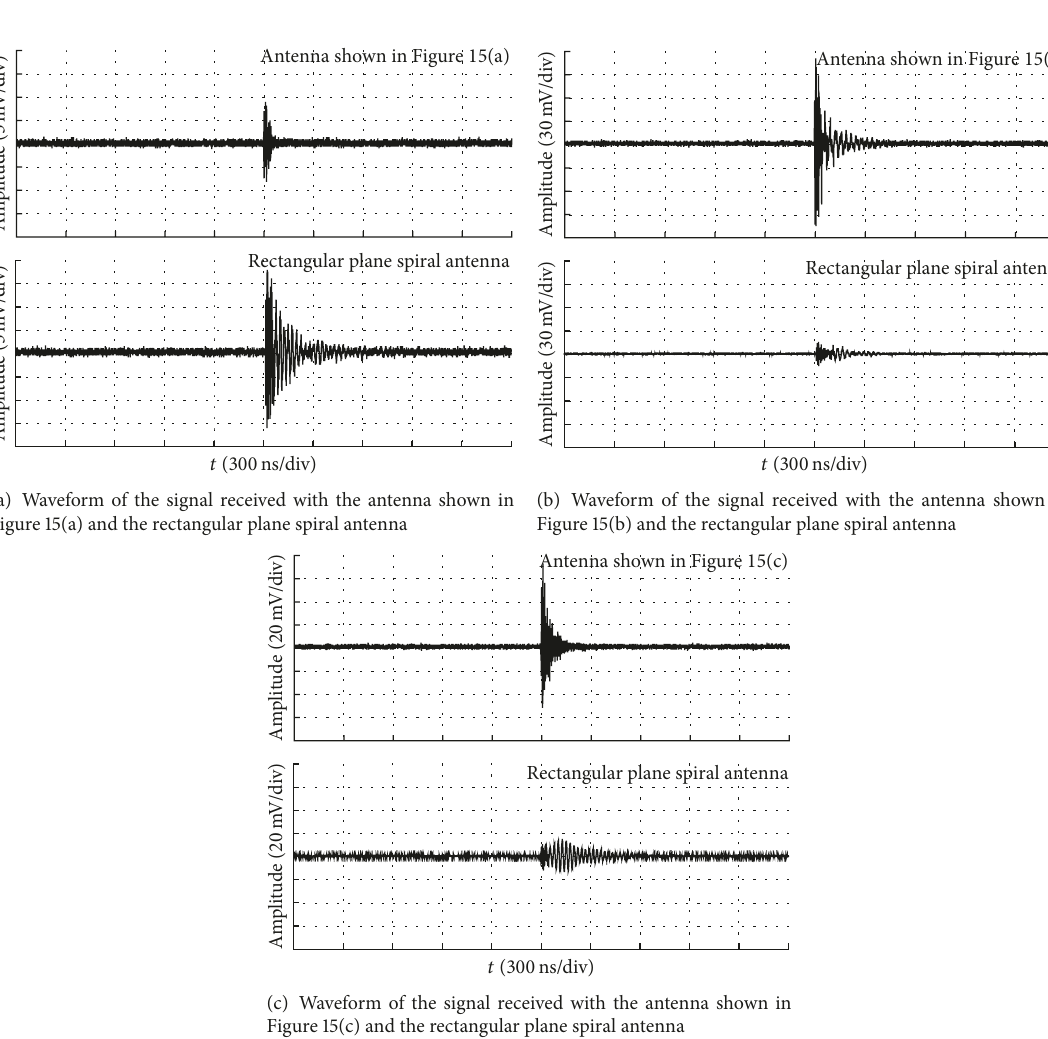
Figure 18: Waveform of the signal received by antennas with three different metal boxes and the rectangular plane spiral antenna.